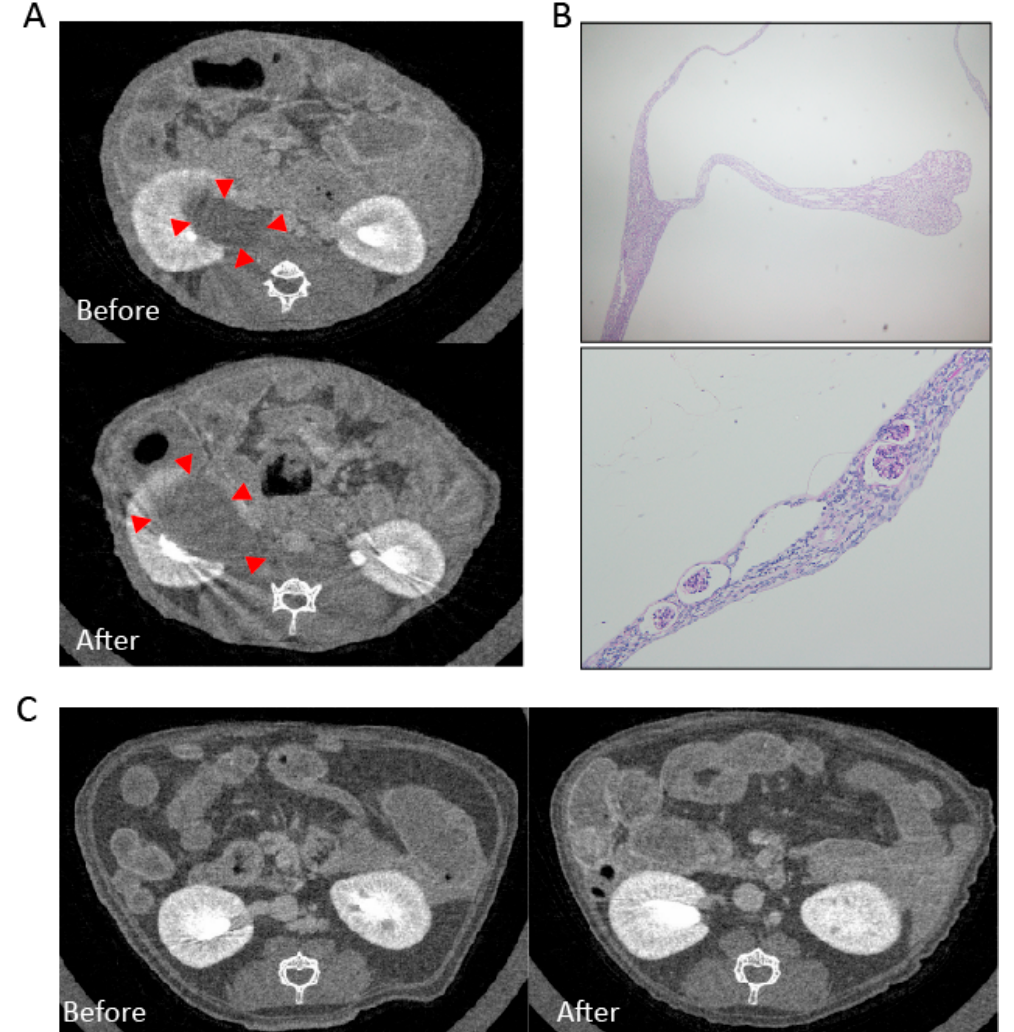
Figure 2. Enlargement of pre-existing cyst after crizotinib administration. Micro-CT images of a mouse show enlargement of kidney cyst after crizotinib treatment ( A ) red arrowheads. Periodic acid–Schiff staining showed compressed glomeruli and tubules ( B ) upper panel at × 40 and lower panel at × 100 magnification. The micro-CT of other mice with no pre-existing cyst show no cystic formation after crizotinib ( C